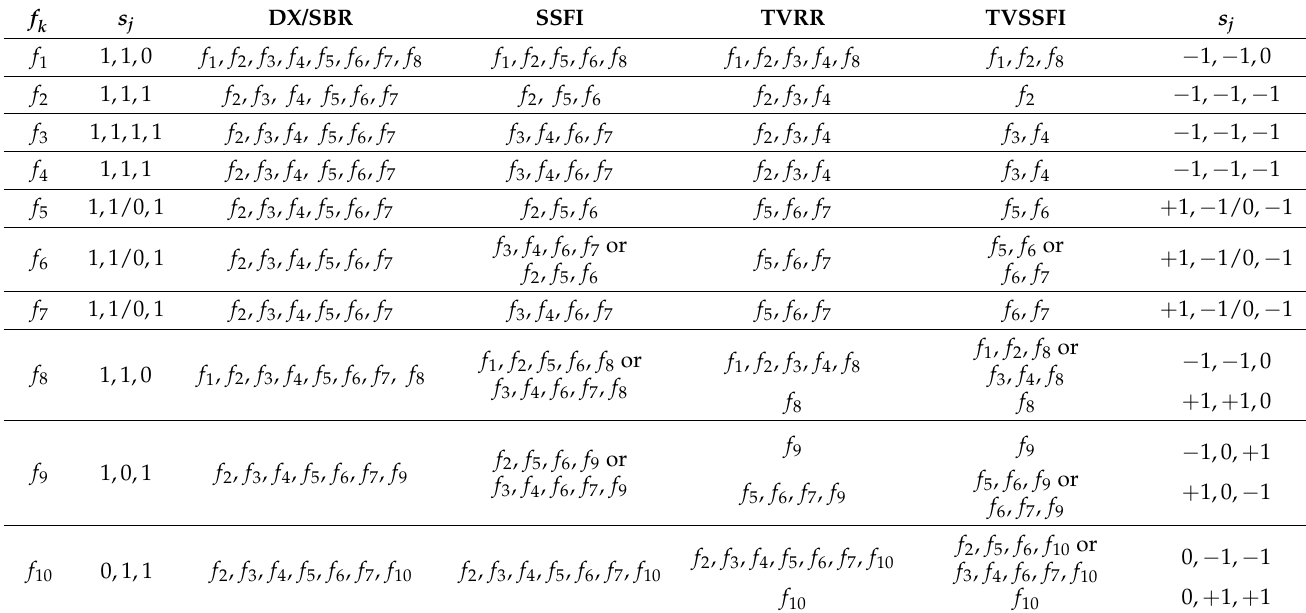
Table 9. List of diagnoses obtained by inference methods on the basis of BMD or FIS rows under the assumption of single